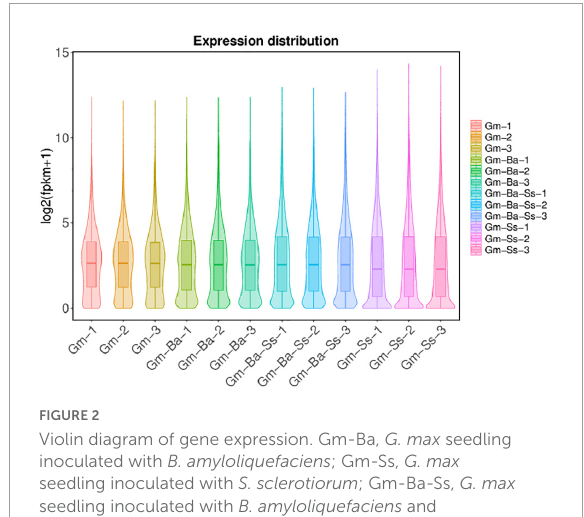
FIGURE2 Violin diagram of gene expression. Gm-Ba, G. max seedling inoculated with B. amyloliquefaciens ; Gm-Ss, G. max seedling inoculated with S. sclerotiorum ; Gm-Ba-Ss, G. max seedling inoculated with B. amyloliquefaciens and S. sclerotiorum ; Gm, control, scratch